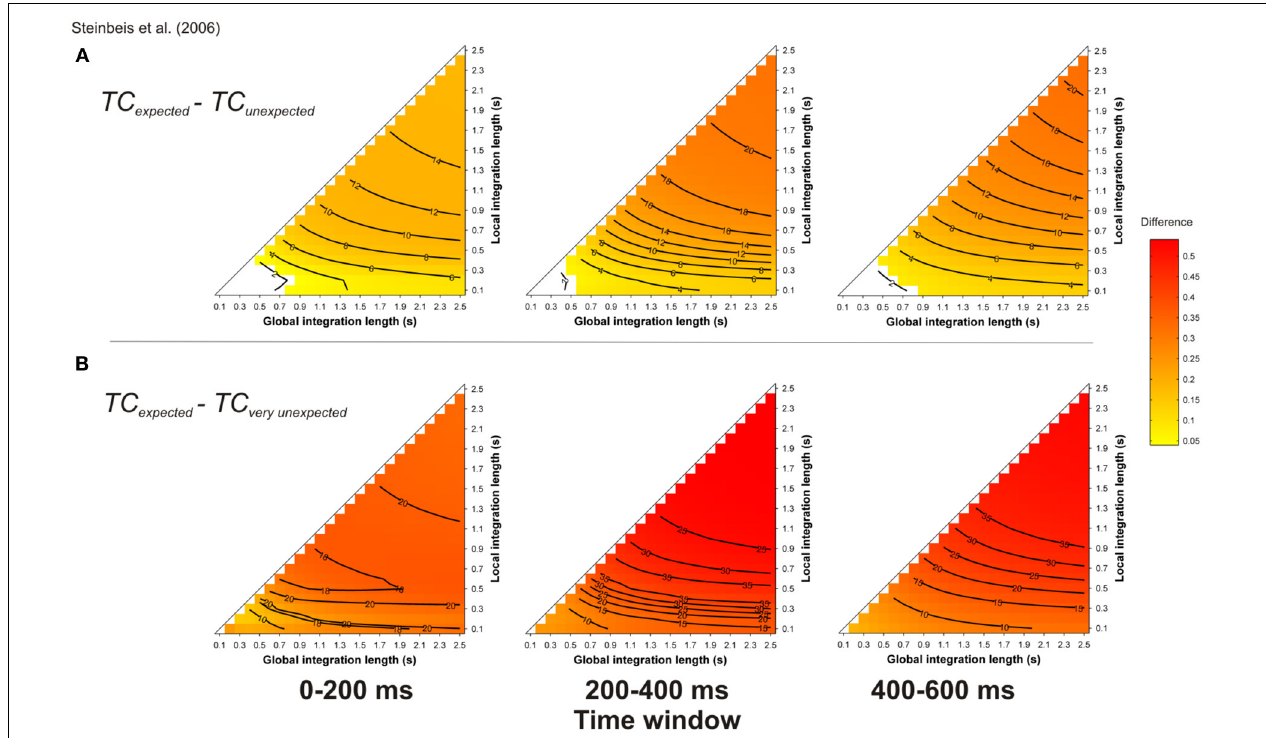
FIGURE 9 | Simulation of Steinbeis et al. (2006). Mean TC differences between expected vs. unexpected (A) and vs. very unexpected (B) target chords, as a function of the local and global context integration windows. Positive, negative, and nonsignificant differences are represented by hot,